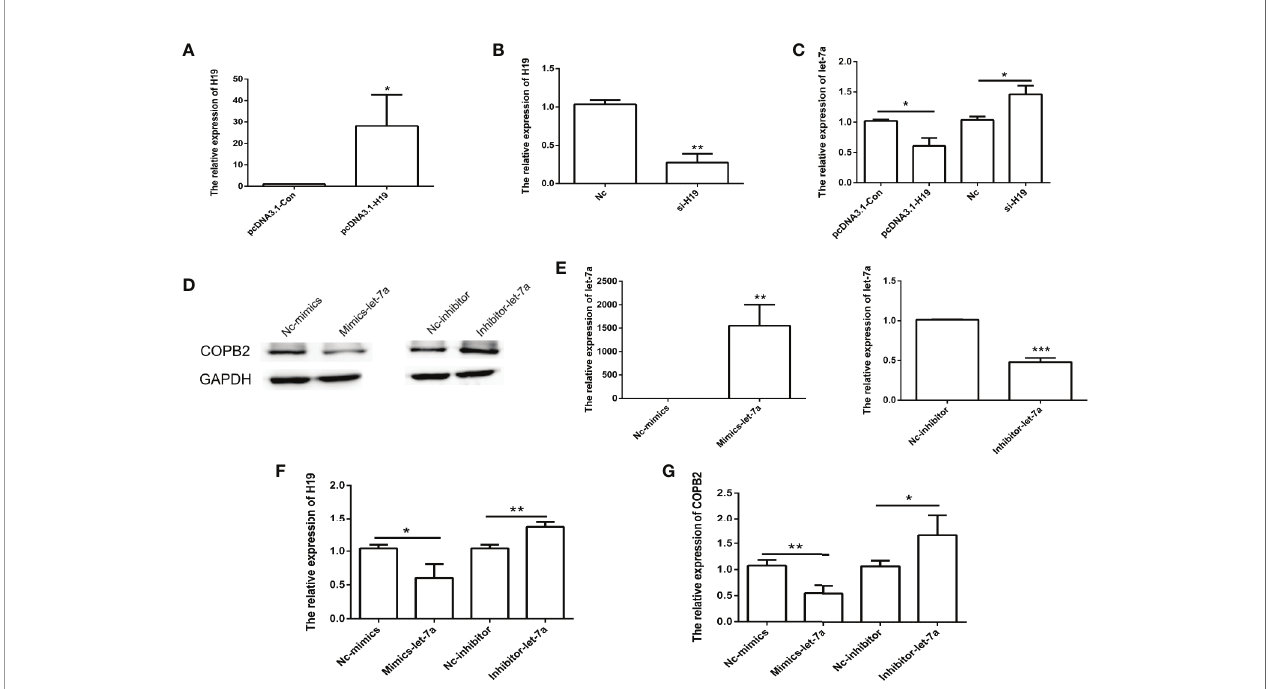
FIGURE 4 | Analysis of COPB2 expression pattern through H19 /let-7a in GC cells. Relative expression of H19 and let-7a in pcDNA3.1-Con, pcDNA3.1-H19, Nc and si-H19 group using qPCR (A – C) . Expression of COPB2 protein in Nc-mimics, mimics-let-7a, Nc-inhibitor and inhibitor-let-7a group using Western blot (D) . Relative expression of let-7a, H19 and COPB2 in Nc-mimics, mimics-let-7a, Nc-inhibitor and inhibitor-let-7a group using qPCR (E – G) . The data are represented as the mean ± SD (n = 3). * ( p < 0.05), ** ( p < 0.01) and *** ( p < 0.001) indicate statistically signi fi cant